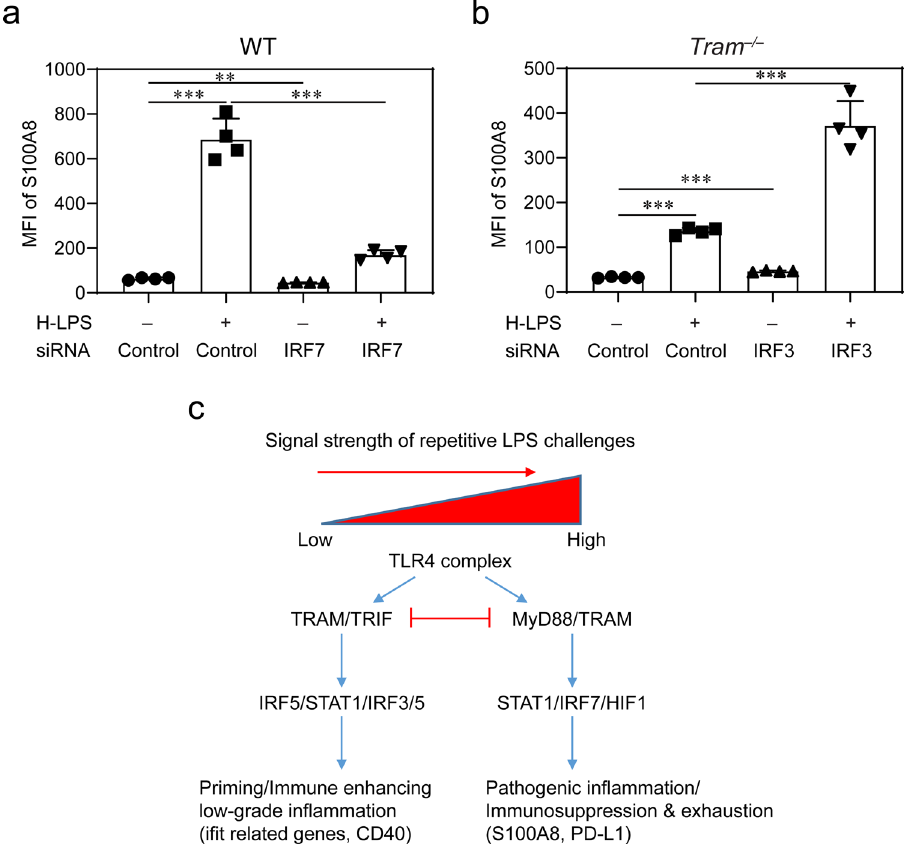
Fig. 7 Causal contribution of TRAM-mediated IRF7 during the generation of exhausted monocytes. a WT monocytes were treated with high-dose LPS (1 µ g/mL) in the presence of IRF7 siRNA or control siRNA for 5 days. The expression of S100A8 was determined with fl ow cytometry. b Tram − / − monocytes were treated with high-dose LPS (1 µ g/mL) in the presence of IRF3 siRNA or control siRNA for 5 days. The expression of S100A8 was determined with fl ow cytometry. Data are representative of three independent experiments, and error bars represent means ± SEM. ** P < 0.01, and *** P < 0.001; one-way ANOVA ( n = 4 for each group). c A schematic summary of the potential dynamics involved in the programming of in fl ammatory monocytes and exhausted